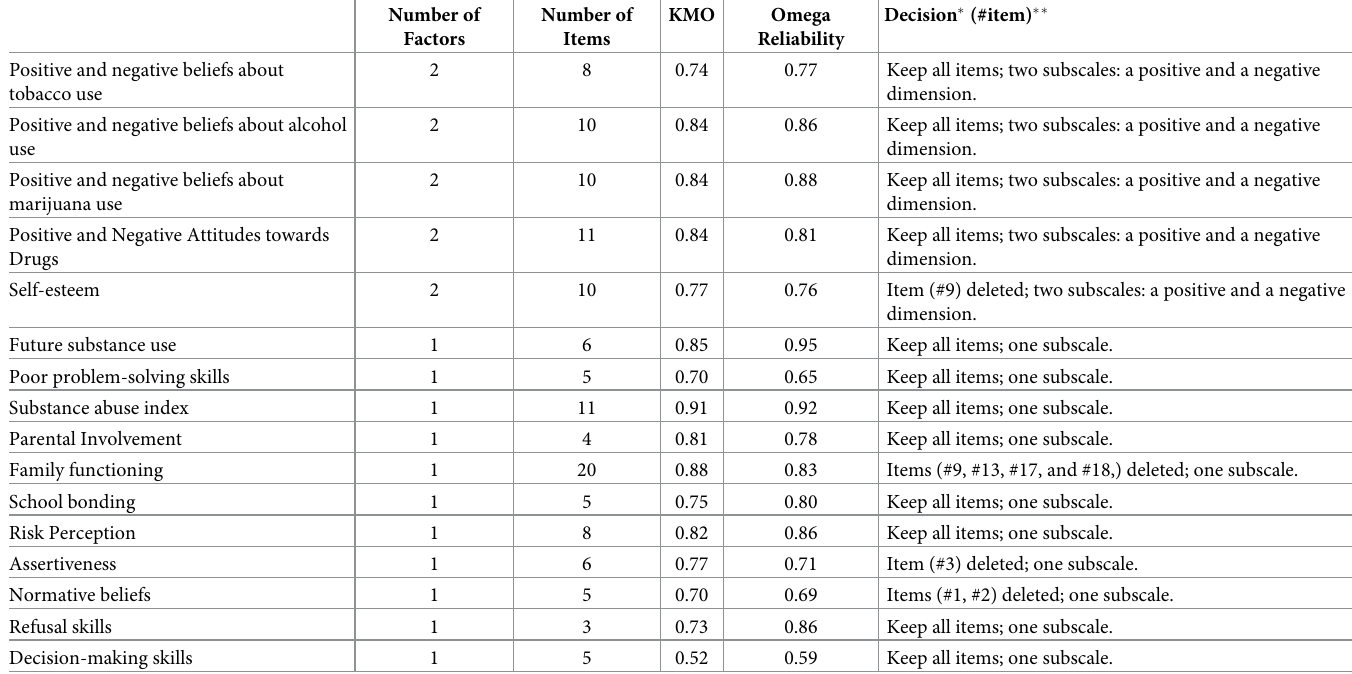
Table 3. Original structure of subscales before removing some